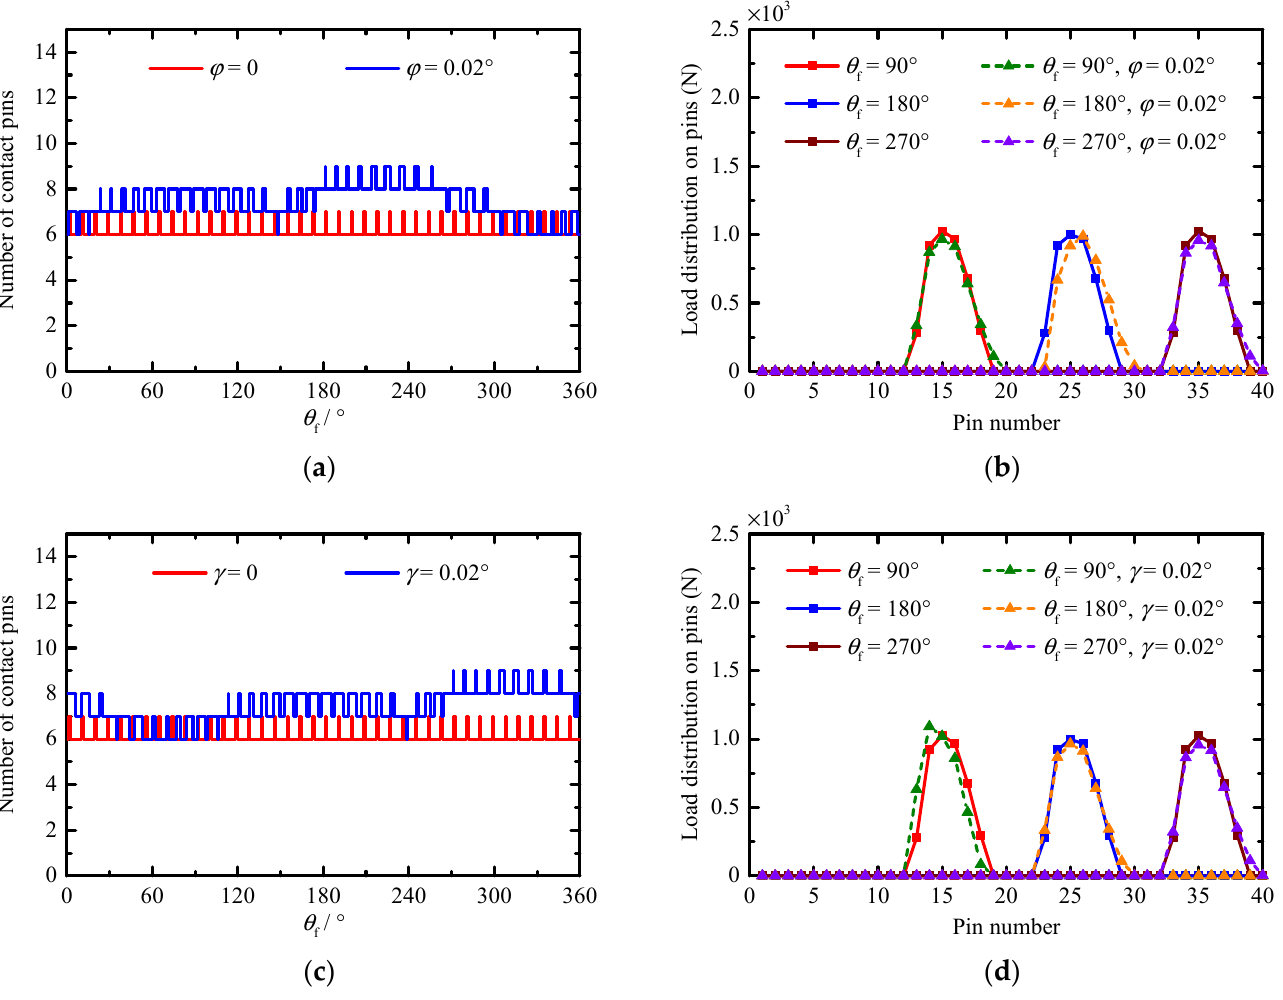
Figure 16. Effect of misalignment deviations on ( a ) number of contact pins ( φ = 0.02°), ( b ) load distribution on pins ( φ = 0.02°), ( c ) number of contact pins ( γ = 0.02°), and ( d ) load distribution on pins ( γ = 0.02°).